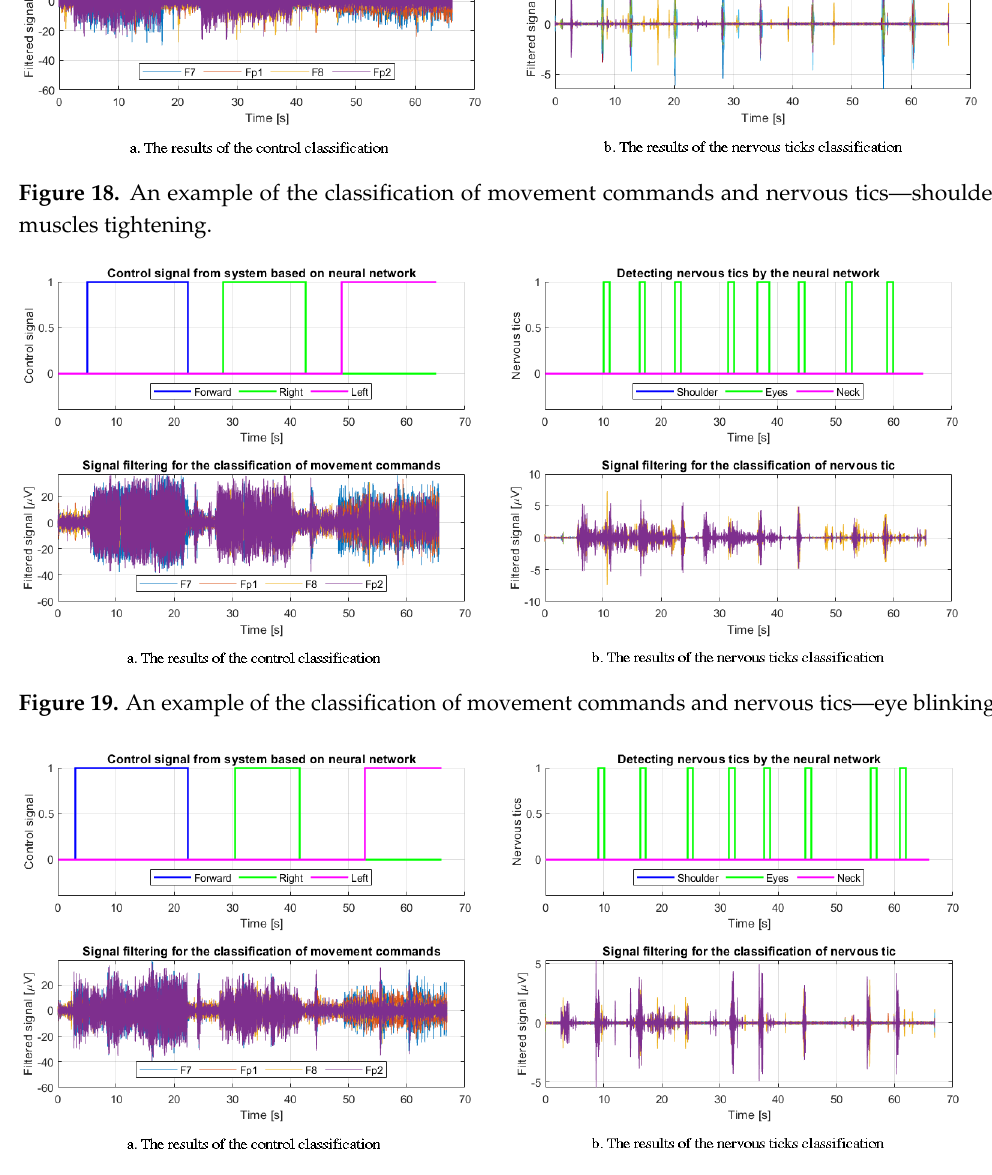
Figure 20. An example of the classification of movement commands and nervous tics—eye